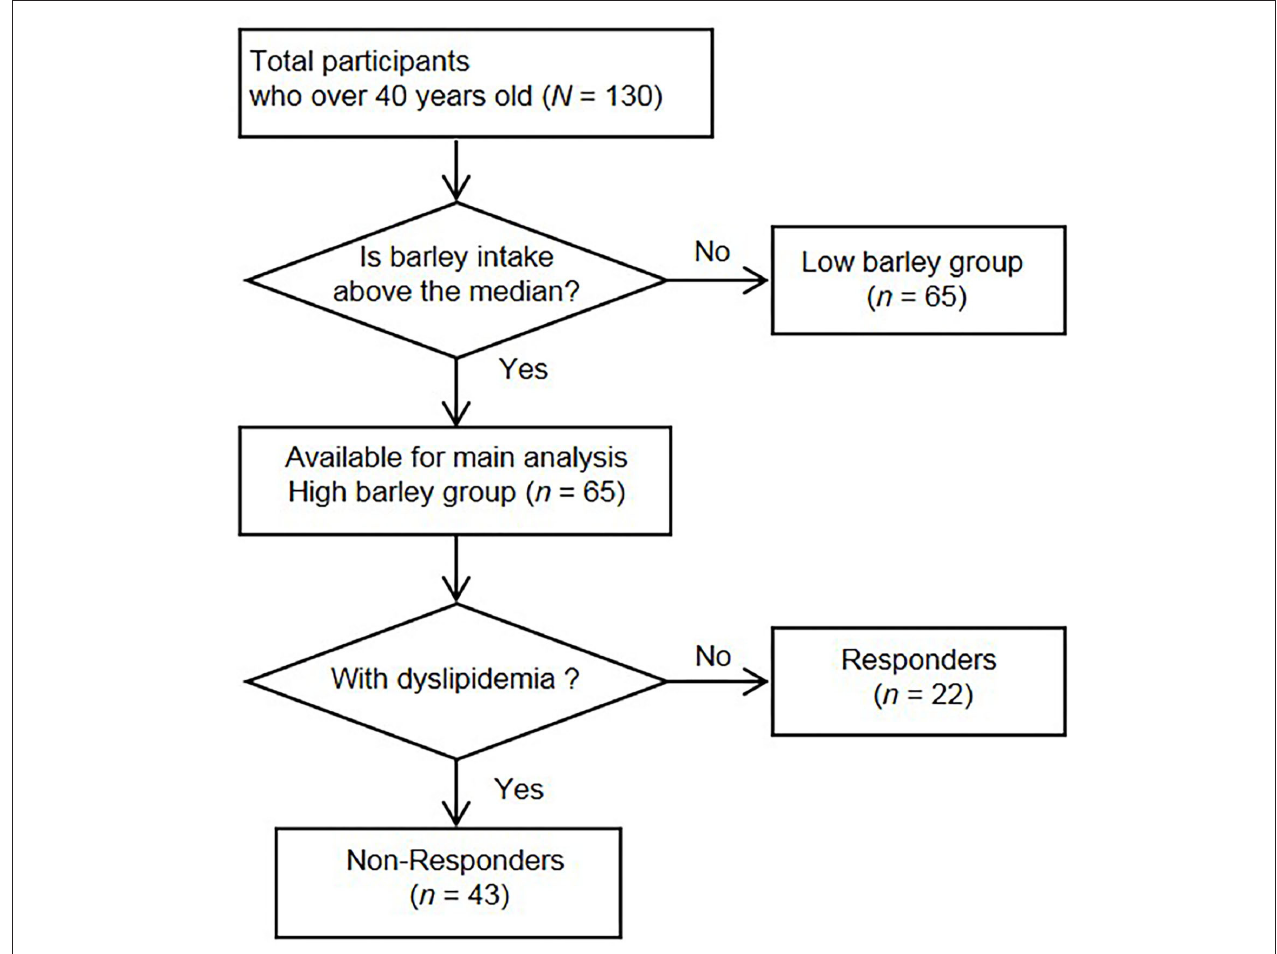
FIGURE 1 | Flow chart of the recruitment and selection of